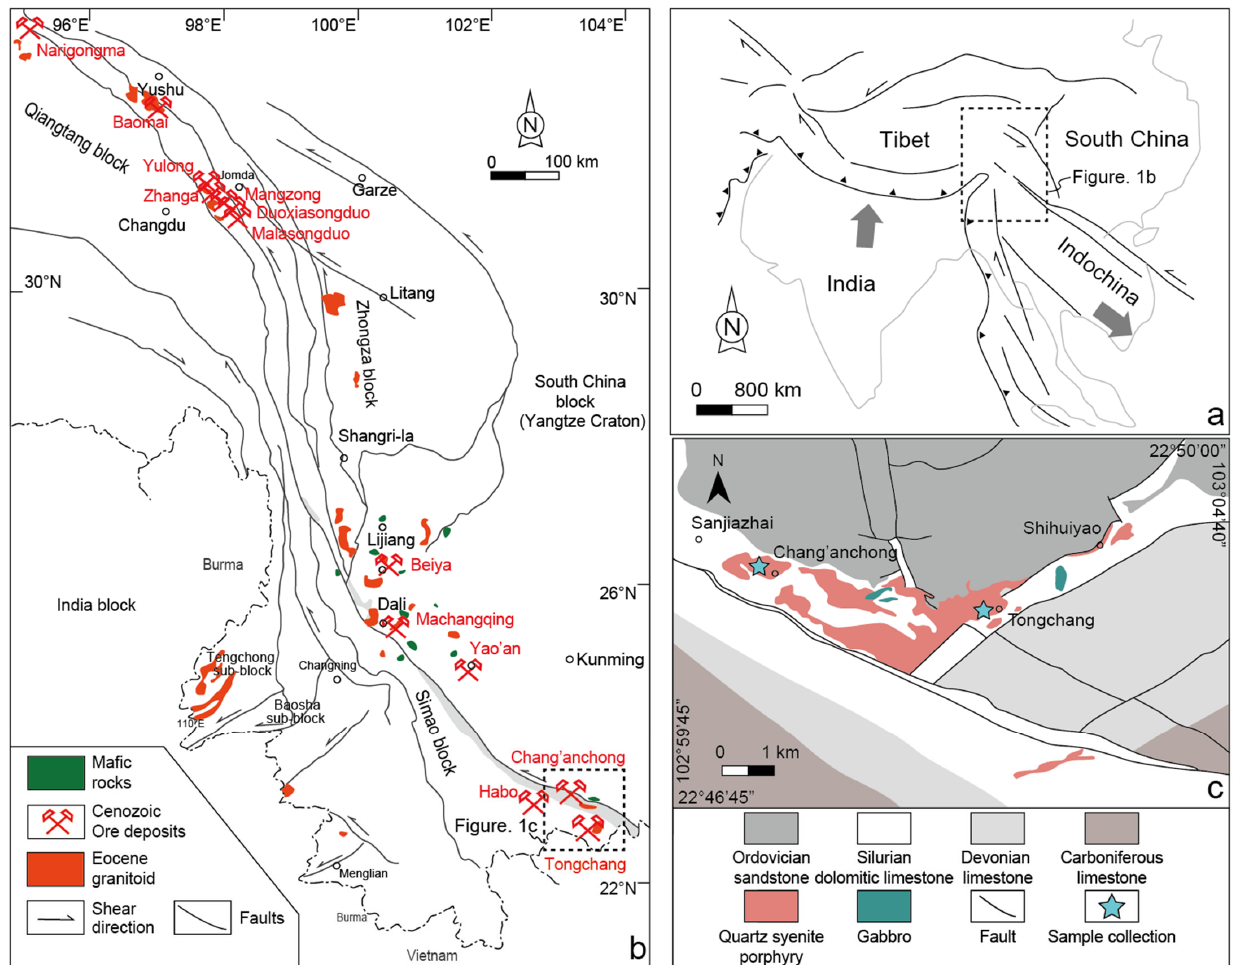
Figure 1. ( a ) Generalized geological map showing major tectonic structures due to the collision be- tween India and Eurasia (revised from [49]); ( b ) Simpli fi ed geological map showing the distribution of Eocene–Oligocene (43–32 Ma) igneous rocks and fertile porphyry Cu–Mo–Au deposits in western Yunnan (modi fi ed from [32,35]); ( c ) Geologic map of the Tongchang–Chang’anchong porphyry